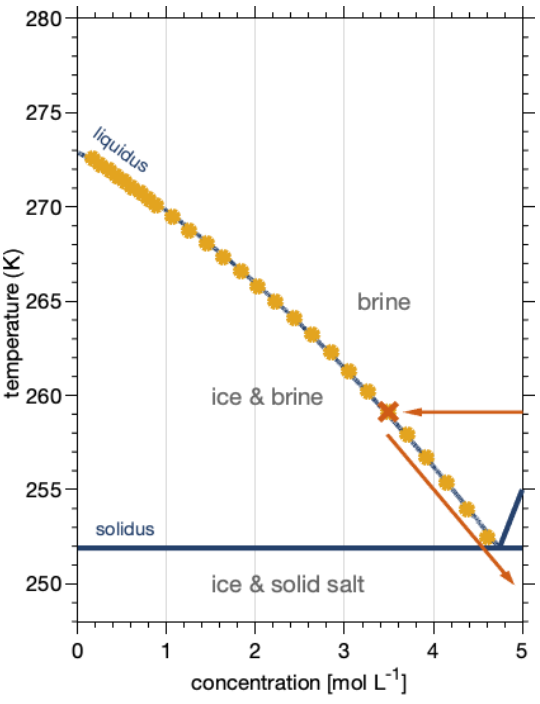
Figure 2. Phase diagram of the sodium chloride–water binary sys- tem. The data show the freezing-point depression of sodium chlo- ride solutions (filled yellow circles) and give the concentration of an aqueous sodium chloride solution in equilibrium with ice in the temperature range of 273 to 254K (Rumble, 2019). The dark-blue lines indicate the phase boundaries (Koop et al., 2000b; Rumble, 2019); that is they denote the so-called liquidus and solidus line, re- spectively, and thus show the temperature and concentration range where ice and aqueous sodium chloride solutions co-exist. The eu- tectic temperature of sodium chloride–water binaries is 251.9K (Koop et al., 2000a). Also shown is a typical experimental proce- dure (red arrows and